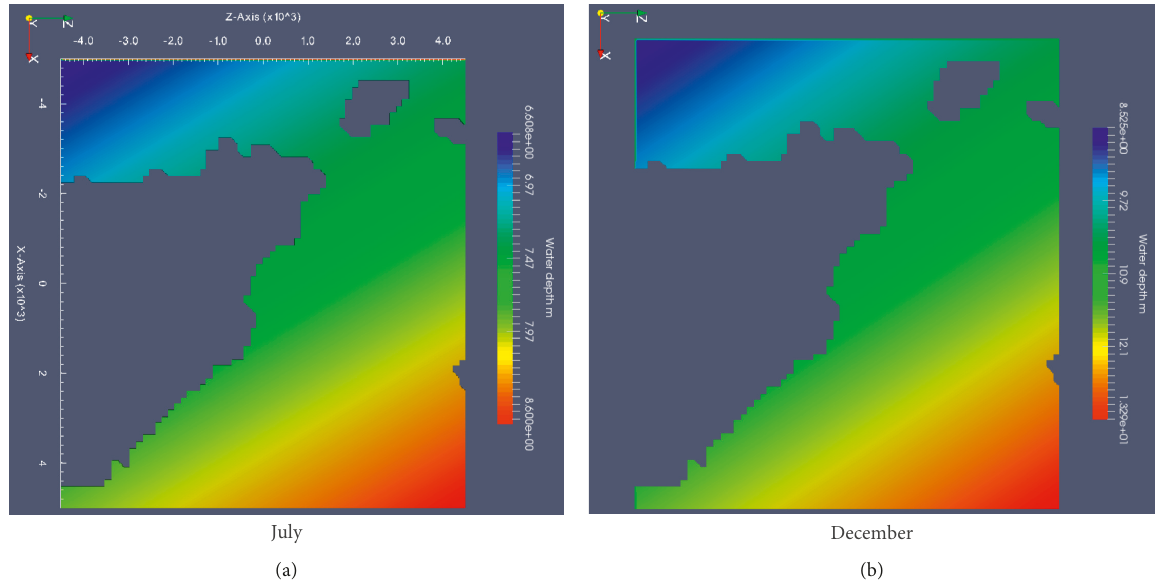
Figure 6: Water depth data by interpolation based on Table 1. (a) July. (b)